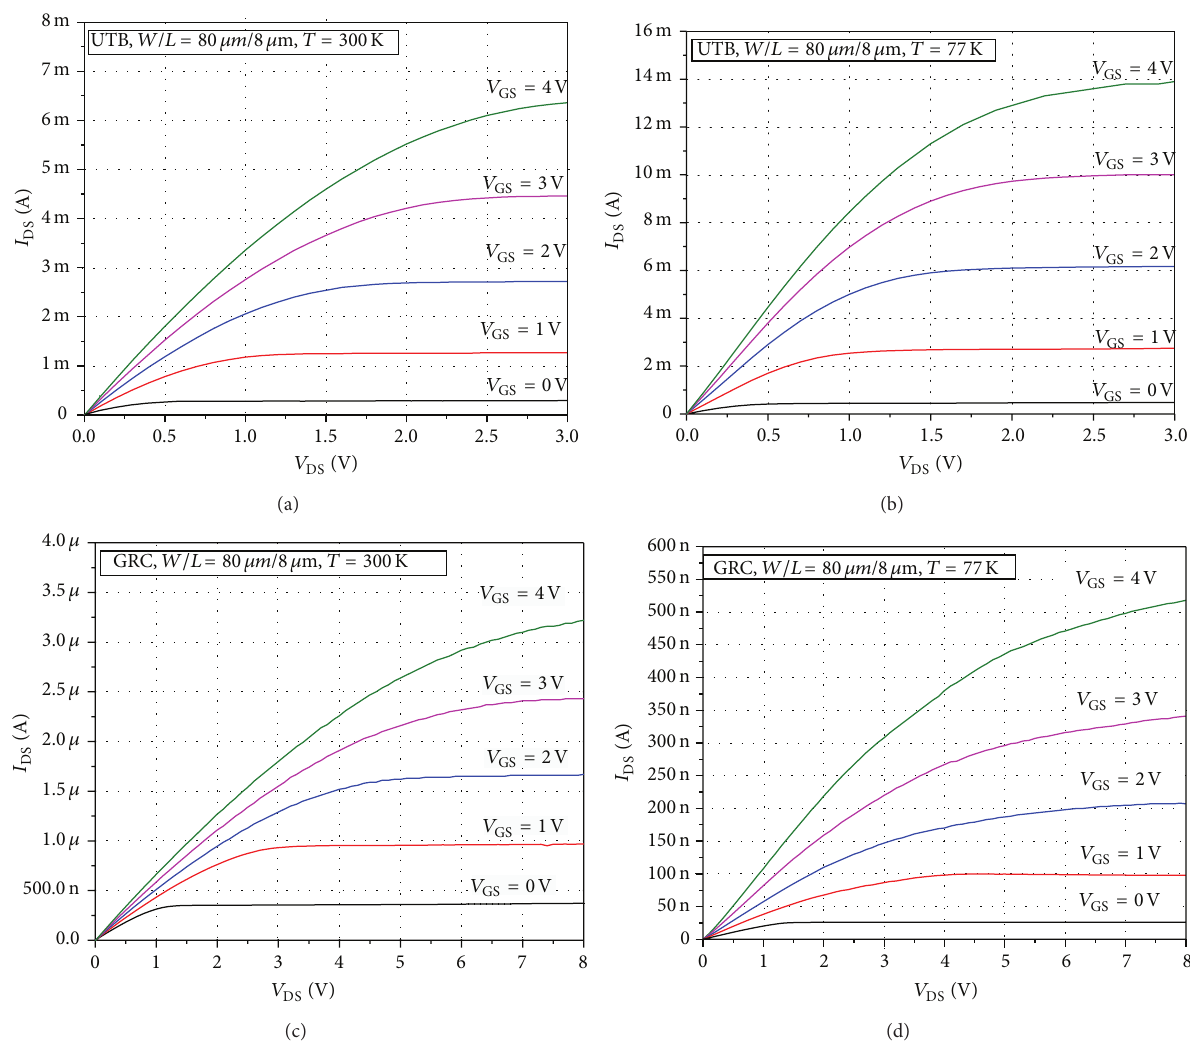
Figure 3: 𝐼 - 𝑉 output characteristics measured for UTB ( 𝑡 DS DS 4 V) and at two temperatures: (a) UTB at 𝑇 = 300 K, (b) UTB at 𝑇 = 77 K, (c) GRC at 𝑇 = 300 K, and (d) GRC at 𝑇 = 77 K.